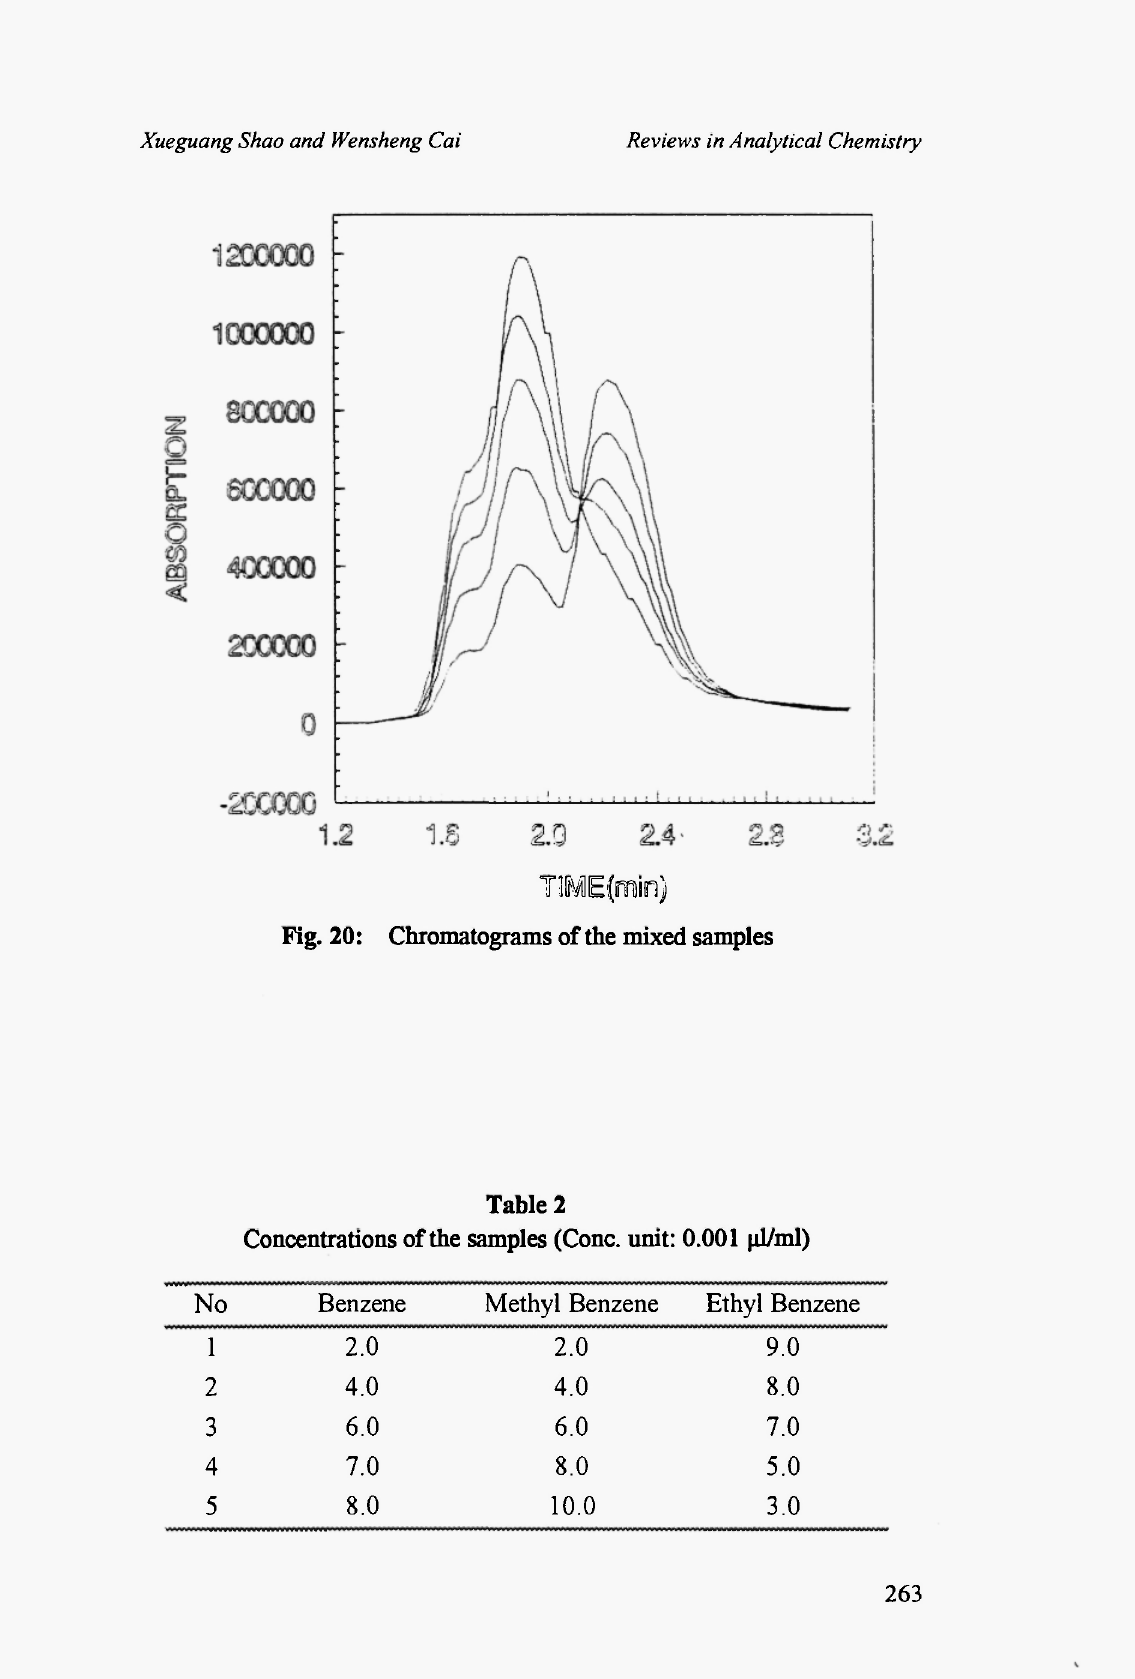
Fig. 20: Chromatograms of the mixed samples